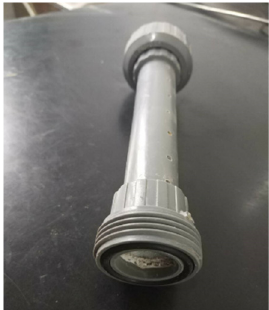
Figure 3. Photo of the crossflow filtration module.